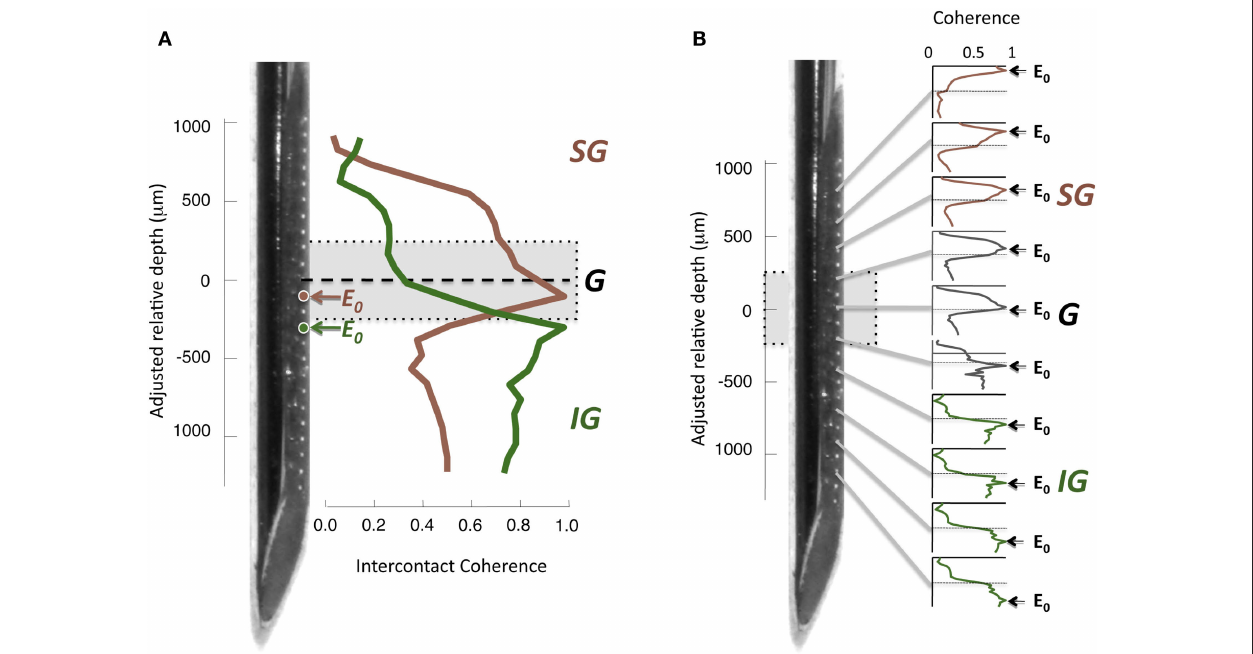
two electrodes chosen for this example (E , red and green) are separated by only 0 200 μm. (B) Laminar pattern of inter-contact coherence for 10 different E 0 contact positions, shown in the same format as in (A) . The E positions in the 0 infragranular layers elicit a pattern of high coherence only in those layers, suggesting that the gamma-range activity in those layers is highly synchronous, but asynchronous to that in other layers. Conversely, E positions in the 0 supragranular layers are coherent only with signals measured in supragranular contacts. A single contact lying just below the zero point appears to be a transition between supra- and infragranular